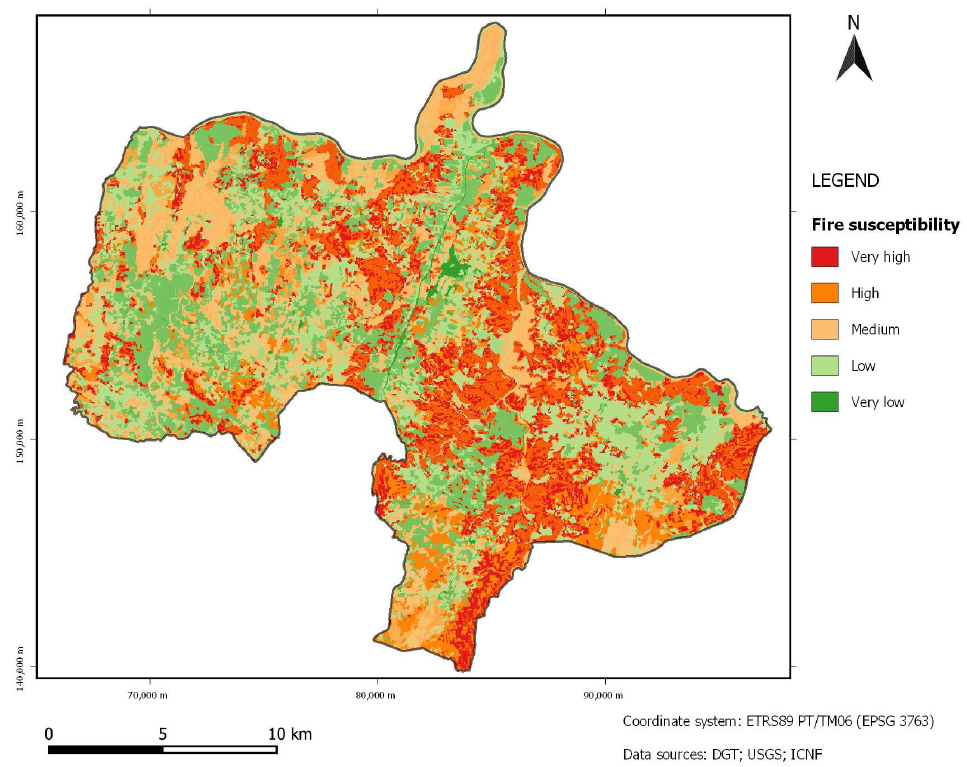
Figure 6. Wildfire susceptibility map for Vila Nova de Foz Côa obtained by running the developed plugin with the land use and slope variables symbolized by quintiles (with linear color interpolation). Table 12. Results of the modeling script combining level 3 COS with every other environmental variable in trios. The value before the semicolon represents the training AUC, while the value after represents the prediction